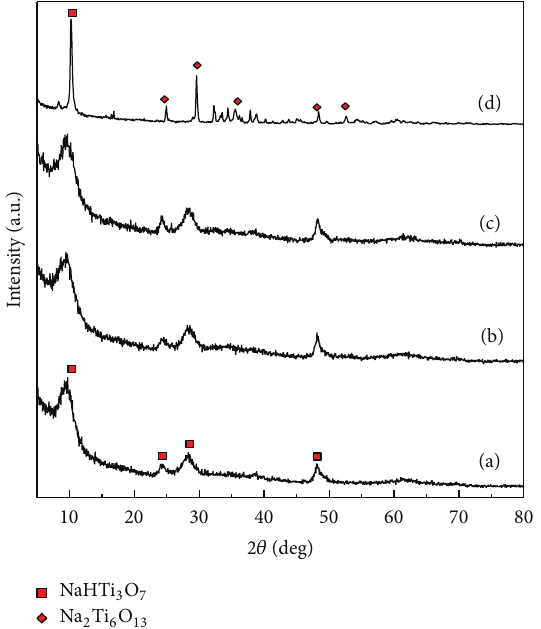
Figure5: XRDpatternsof thesamples prepared at different reaction temperatures: (a) 110 ∘ C, (b) 130 ∘ C, (c) 150 ∘ C, and (d) 180 ∘ C.